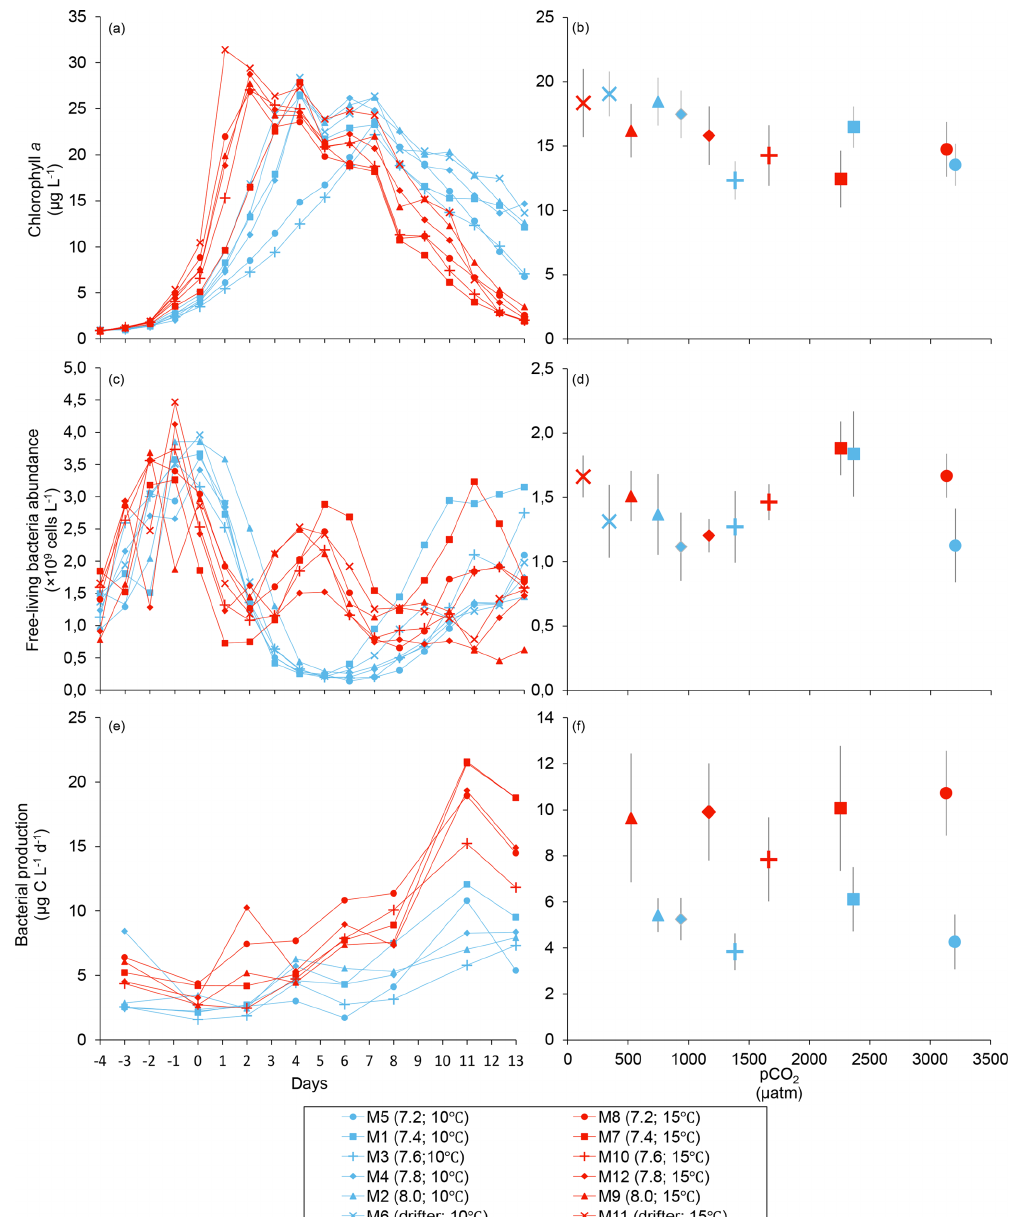
Figure 2. Temporal variations and averages over the course of the experiment (day 0 to day 13) for (a–b) chlorophyll a (adapted from Bénard et al., 2018a), (c–d) free-living bacterial abundance, and (e–f) bacterial production. For symbol attribution to treatments, see the